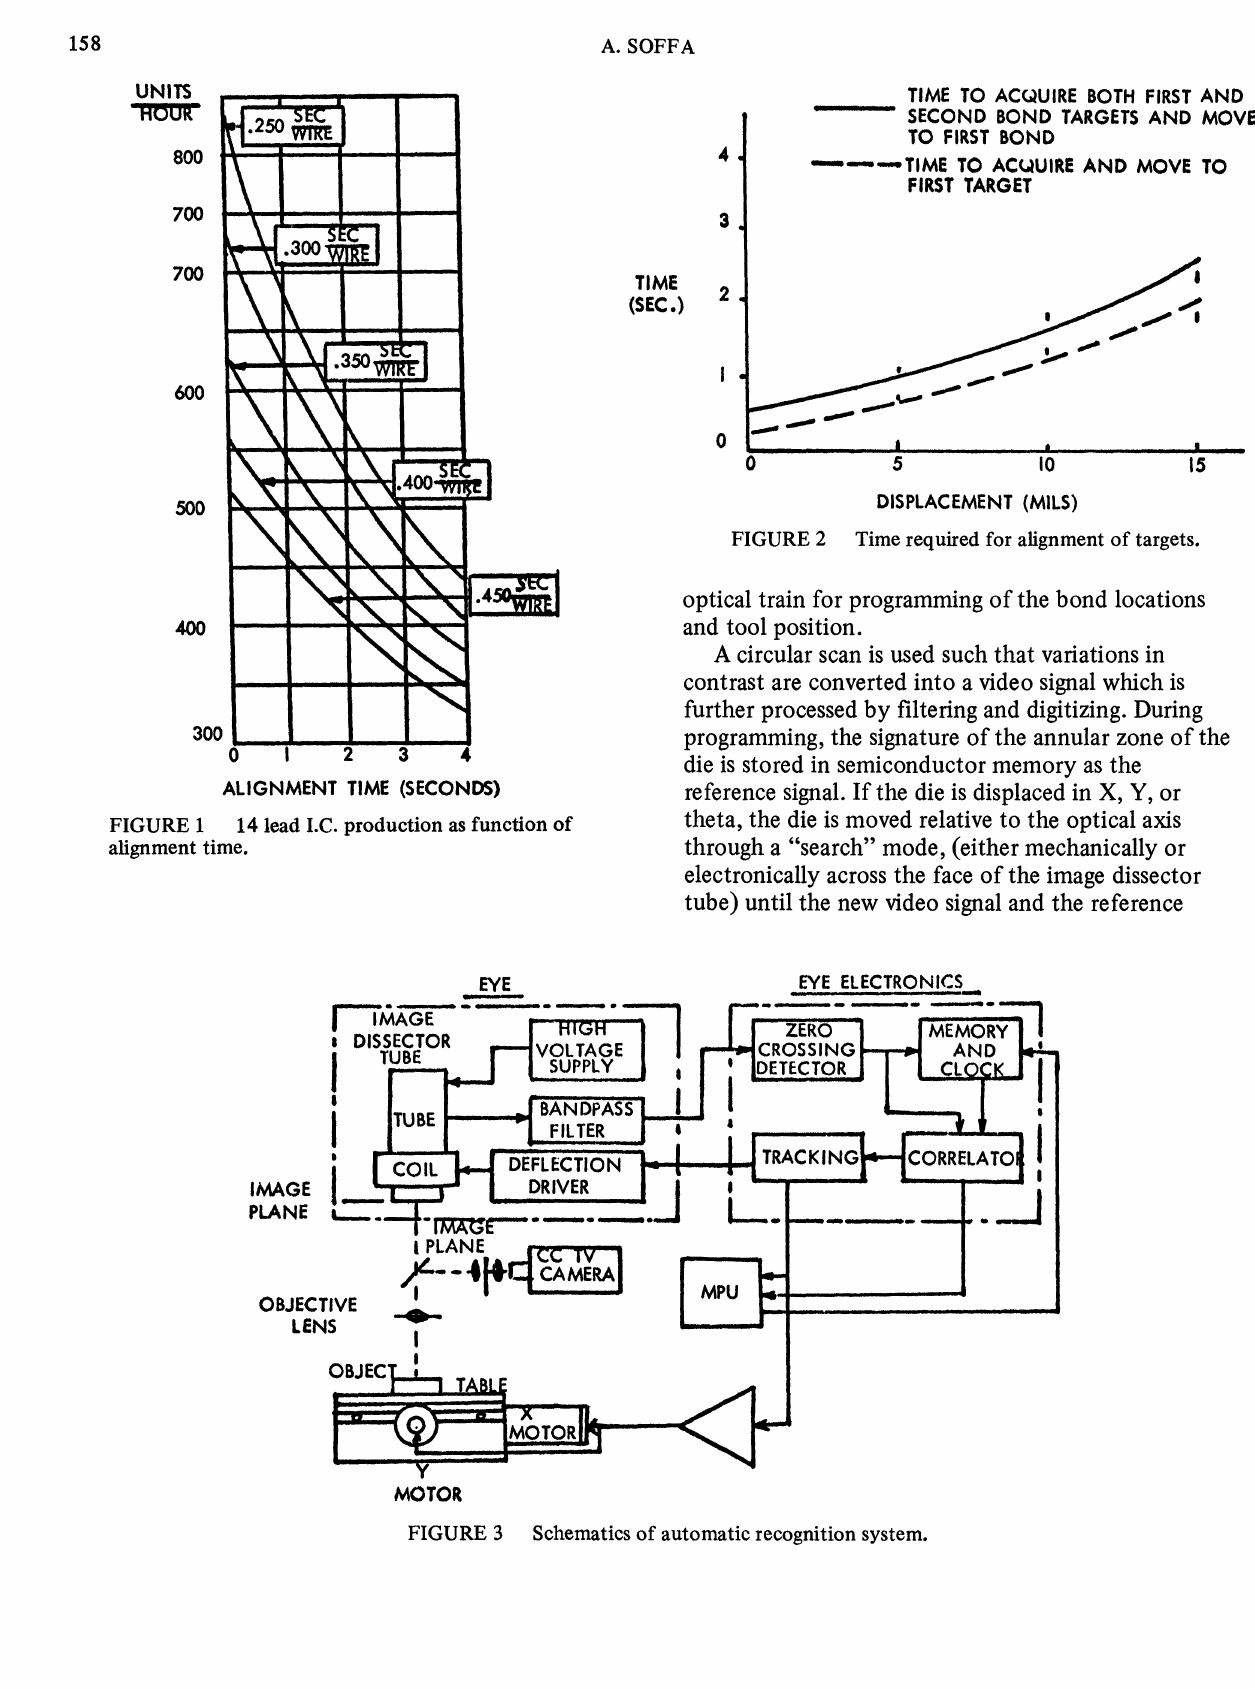
Schematics of automatic recognition